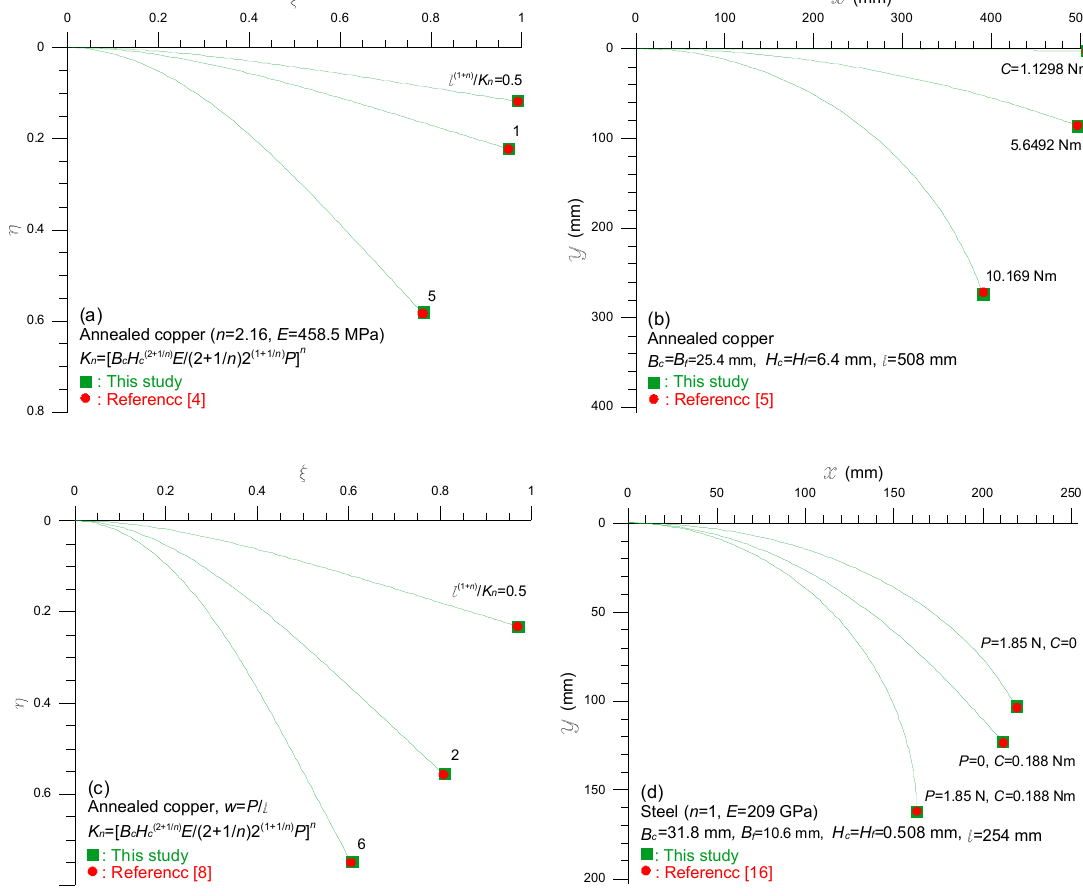
Figure 3. Comparisons of tip responses from this study ( (cid:4) ) and those from the literature ( • ) for four degenerate cases: ( a ) prismatic nonlinear elastic beam with P [4], ( b ) prismatic nonlinear elastic beam with C [5], ( c ) prismatic nonlinear elastic beam with P and W (= P / l ) [8], and ( d ) non-prismatic linear elastic beam with P and C